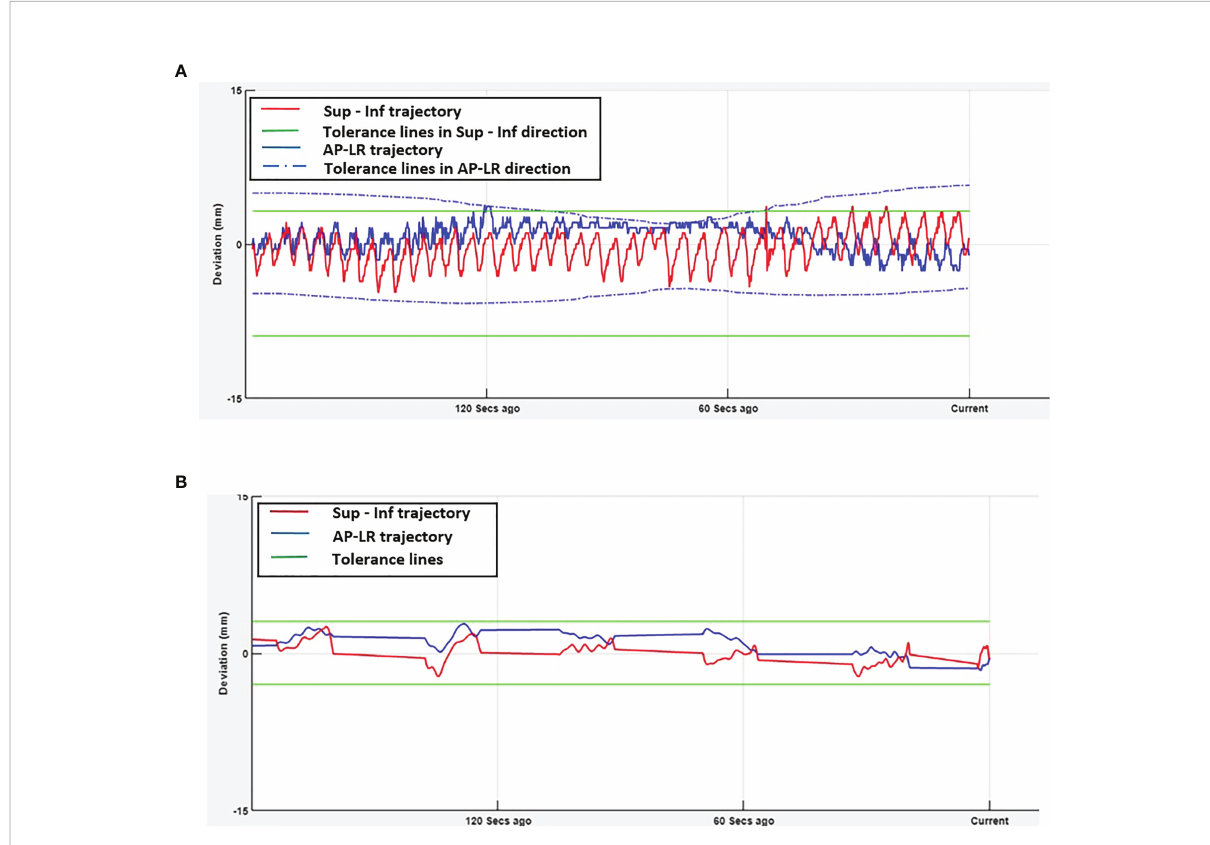
FIGURE 1 Real-time tumour trajectory determined by SeedTracker system. (A) Target trajectory determined during Arc-1 of a patient treated using free-breathing technique. The tolerance window consists of the ITV extent + 3mm position tolerance. The green (solid) and blue (dotted) lines represent the tolerance window in SI and AP-LR directions respectively. (B) Target trajectory determined during Arc-1 of a patient treated using EBH technique. The green (solid) lines represent the tolerance window in SI and AP-LR